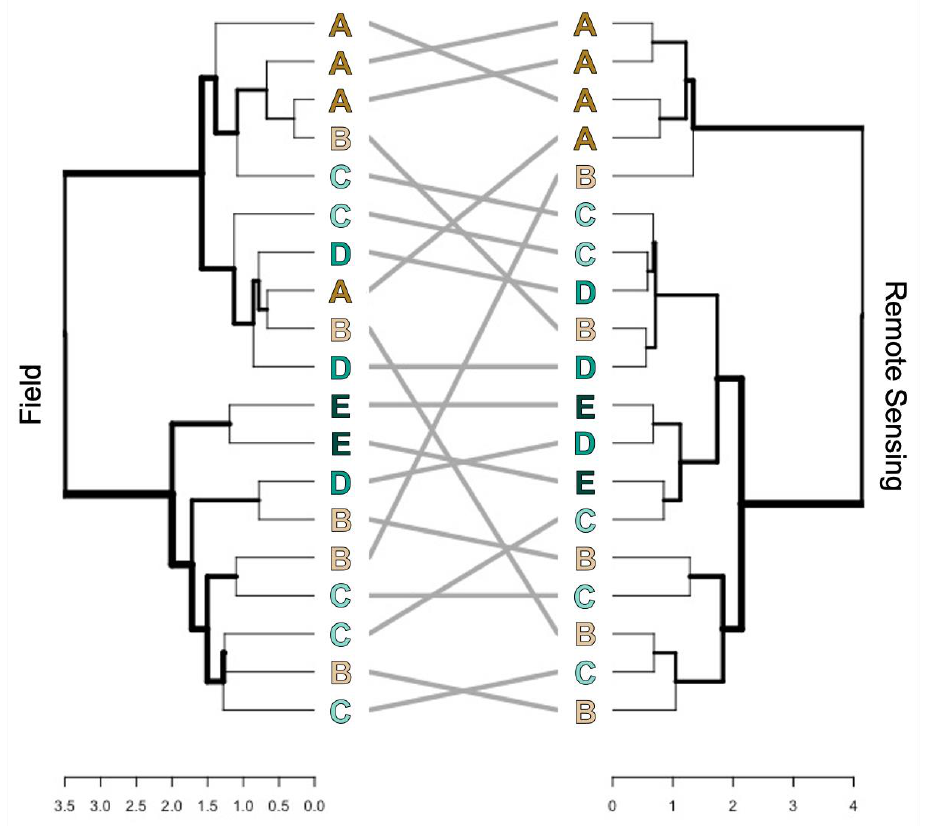
Figure 6. Tanglegram comparing dendrograms of BC between the field data (left) and RS data (right) based on hierarchical clustering. Gray lines connect corresponding sites between the two dendrograms, and sites are labeled according to their age grouping: (A) active sites, (B) 25–50 yo, (C) 60–80 yo, (D) >100 yo, (E) primary forest sites .